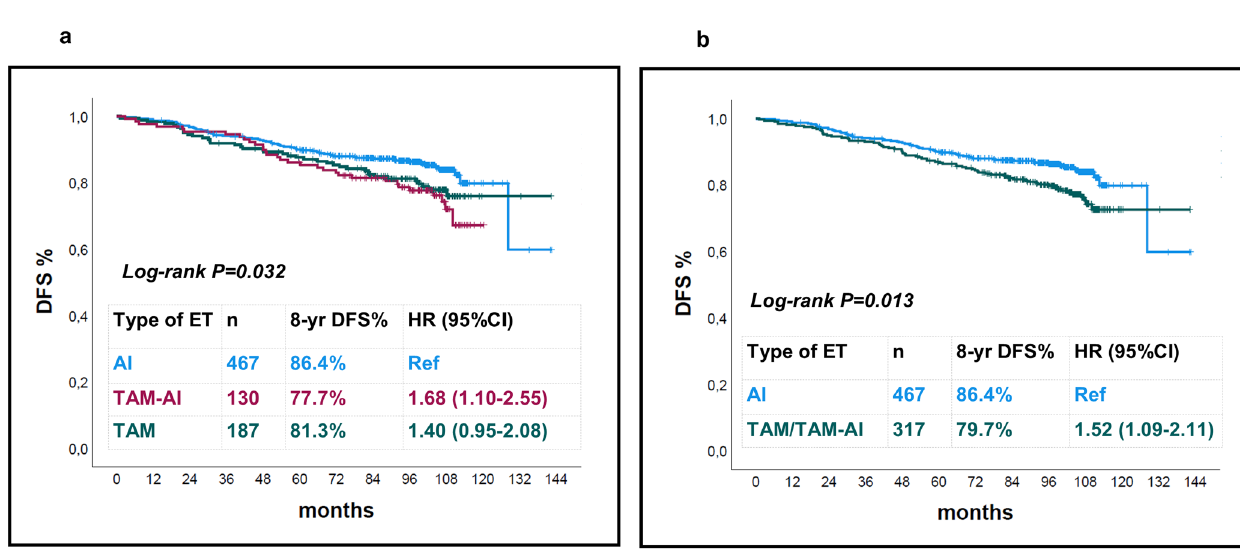
Fig. 1 DFS Kaplan – Meier curves according to the type of adjuvant ET. Comparison of AI vs TAM-AI vs TAM ( a ) and comparison of AI vs TAM/ TAM-AI ( b